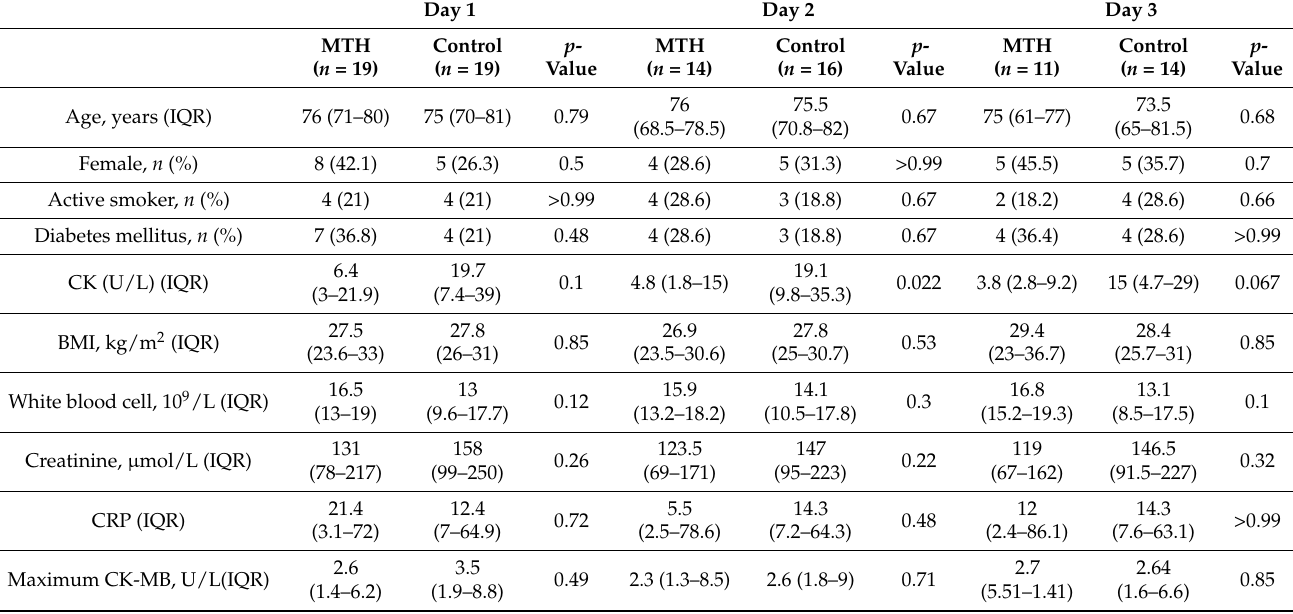
Table 1. Demographic and clinical characteristics of patients during three days of